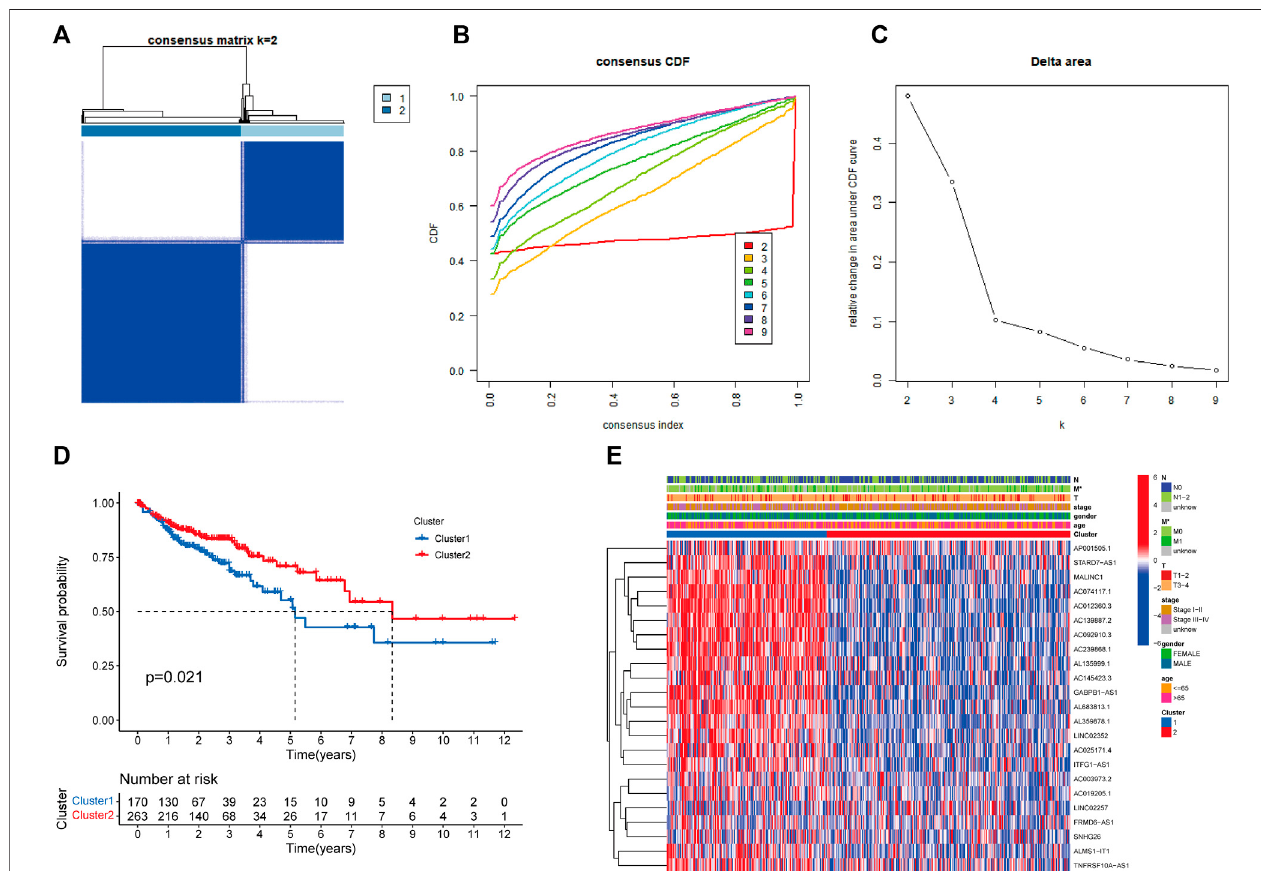
FIGURE4| Overallsurvivaland clinicalcharacteristicsofdifferentsubgroups ofCC. (A) Consensus matrix at optimal k =2. (B) Thecumulativedistributionfunction (CDF)from k =2to9. (C) Relative variation oftheareaunder theCDF region at k =2 – 9. (D) Kaplan-Meier curves oftheoverall survival(OS)time ofcluster 1and cluster2 ( p = 0.021). (E) Heatmap of clinical characteristics and 23 prognostic lncRNA expressions among the two clusters. *p <